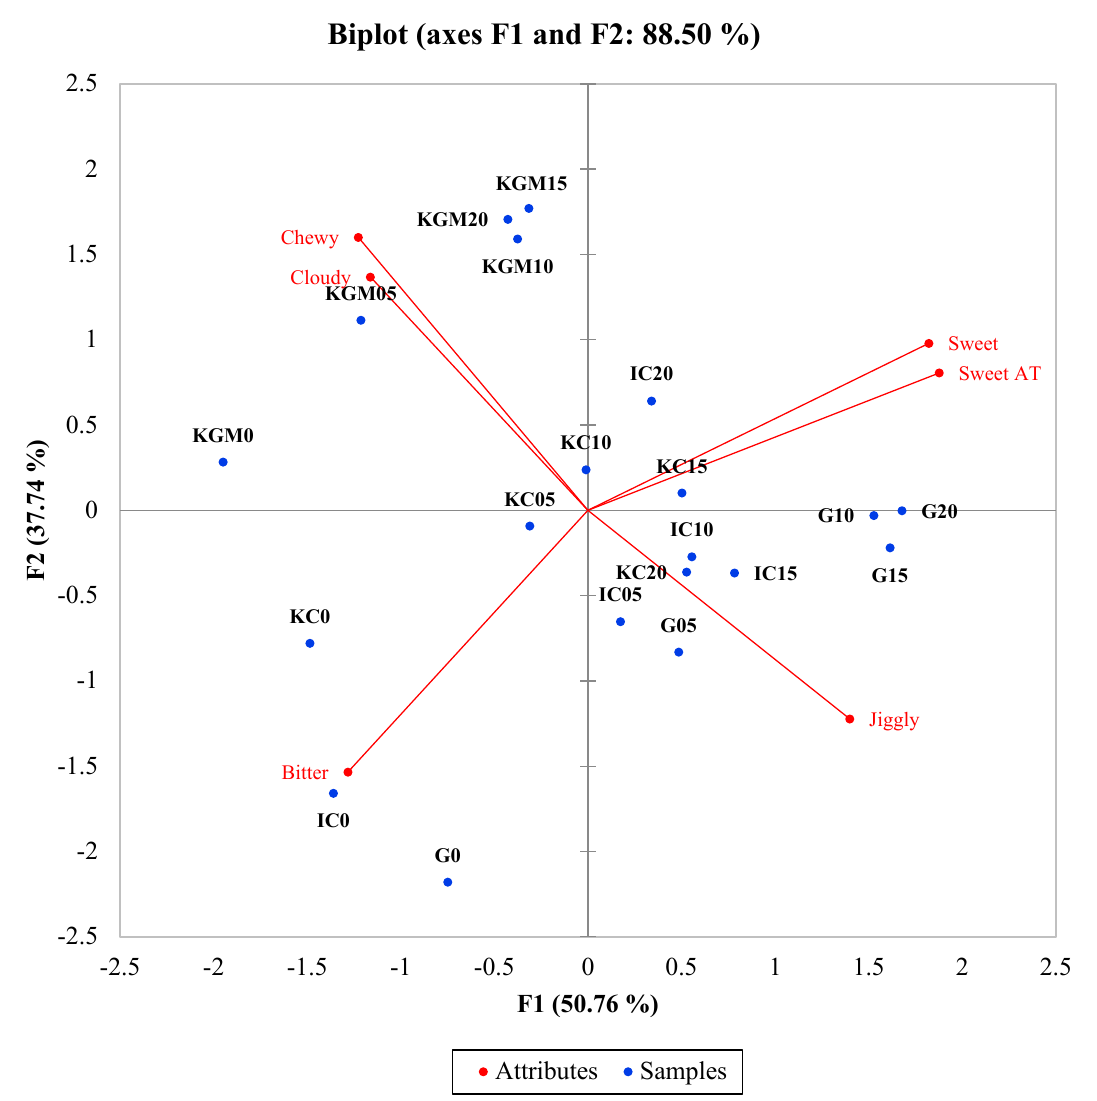
Figure 2. Principal components analysis biplot of Factors 1 and 2 by the correlation matrix of mean six sensory attributes across the 20 model confectionary gel samples based on sugar concentration. AT = aftertaste, G = gelatin, IC = ι -carrageenan, KC = κ -carrageenan, KGM = konjac glucomannan. Cluster analysis was conducted on the significant attributes for gel type and sugar concentration. In both, the dendrogram for gel type and the dendrogram for sugar con- centration, three major clusters were identified, and generally the gel types are clustered together, regardless of sugar concentration (Figures 3 and 4). This is similar to the findings of Suebsaen et al. (2019) [38], where the gelling agent used to formulate banana gel desserts